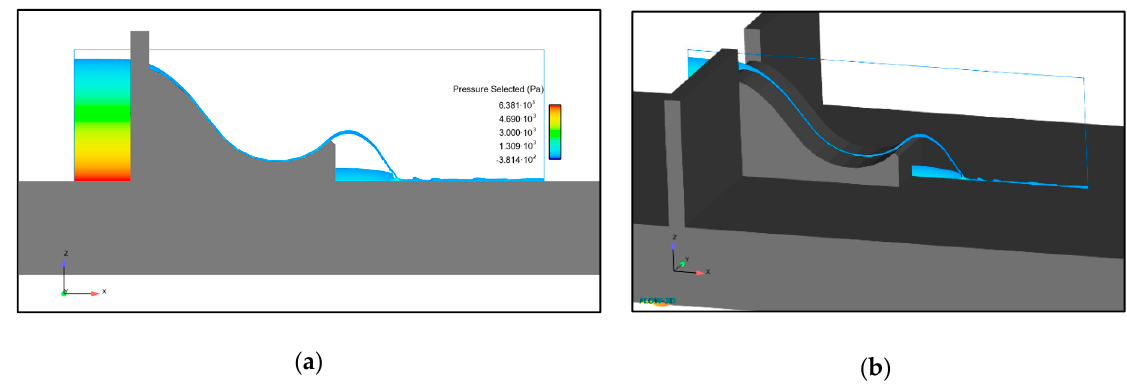
Figure 9. Geometric model implemented in Flow3D: ( a ) 2D view; ( b ) 3D view.